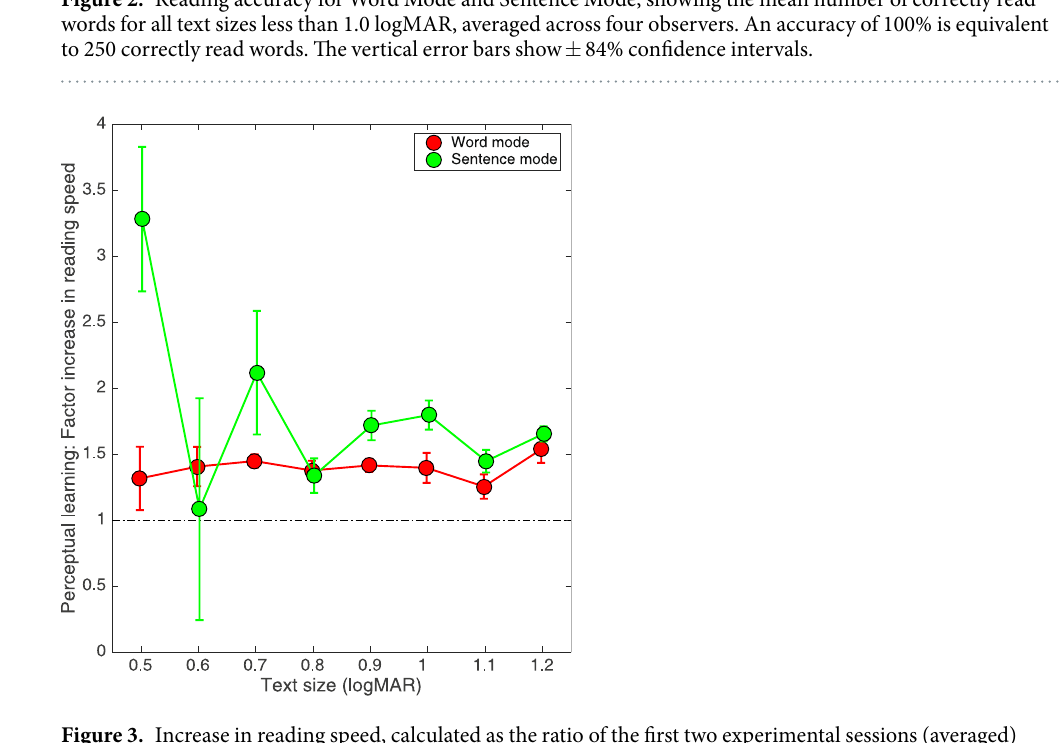
Figure 3. Increase in reading speed, calculated as the ratio of the first two experimental sessions (averaged) divided by the last two sessions (averaged). Results, averaged across four observers, are shown for both Word Mode (red circles) and Sentence Mode (green circles) as a function of text size (logMAR). Error bars ( ± 84% CI) represent inter-observer